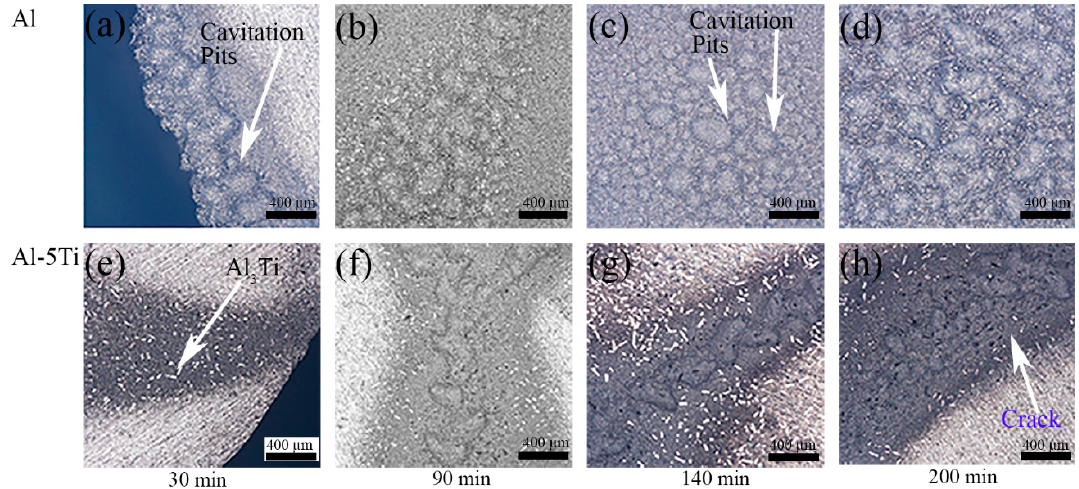
Figure 5. Damaged surface of Al and Al-5Ti alloys after different cavitation erosion time.